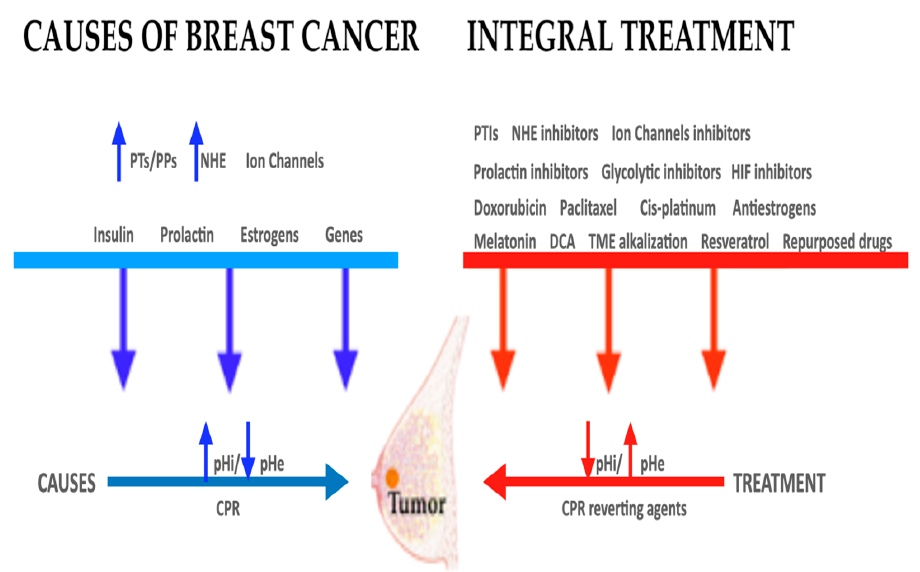
Figure 1. pH-related causes and available treatments for breast cancer. PTs: proton transporters; PPs: protonpumps: PTIs: protontransportinhibitors; PPIs: protonpumpinhibitors; NHE:sodium–hydrogen exchanger; HIF: hypoxia-inducing factor; TME: tumor microenvironment; DCA: dichloroacetate. Blue arrows indicate causes of breast cancer. Red arrows indicate treatments of breast